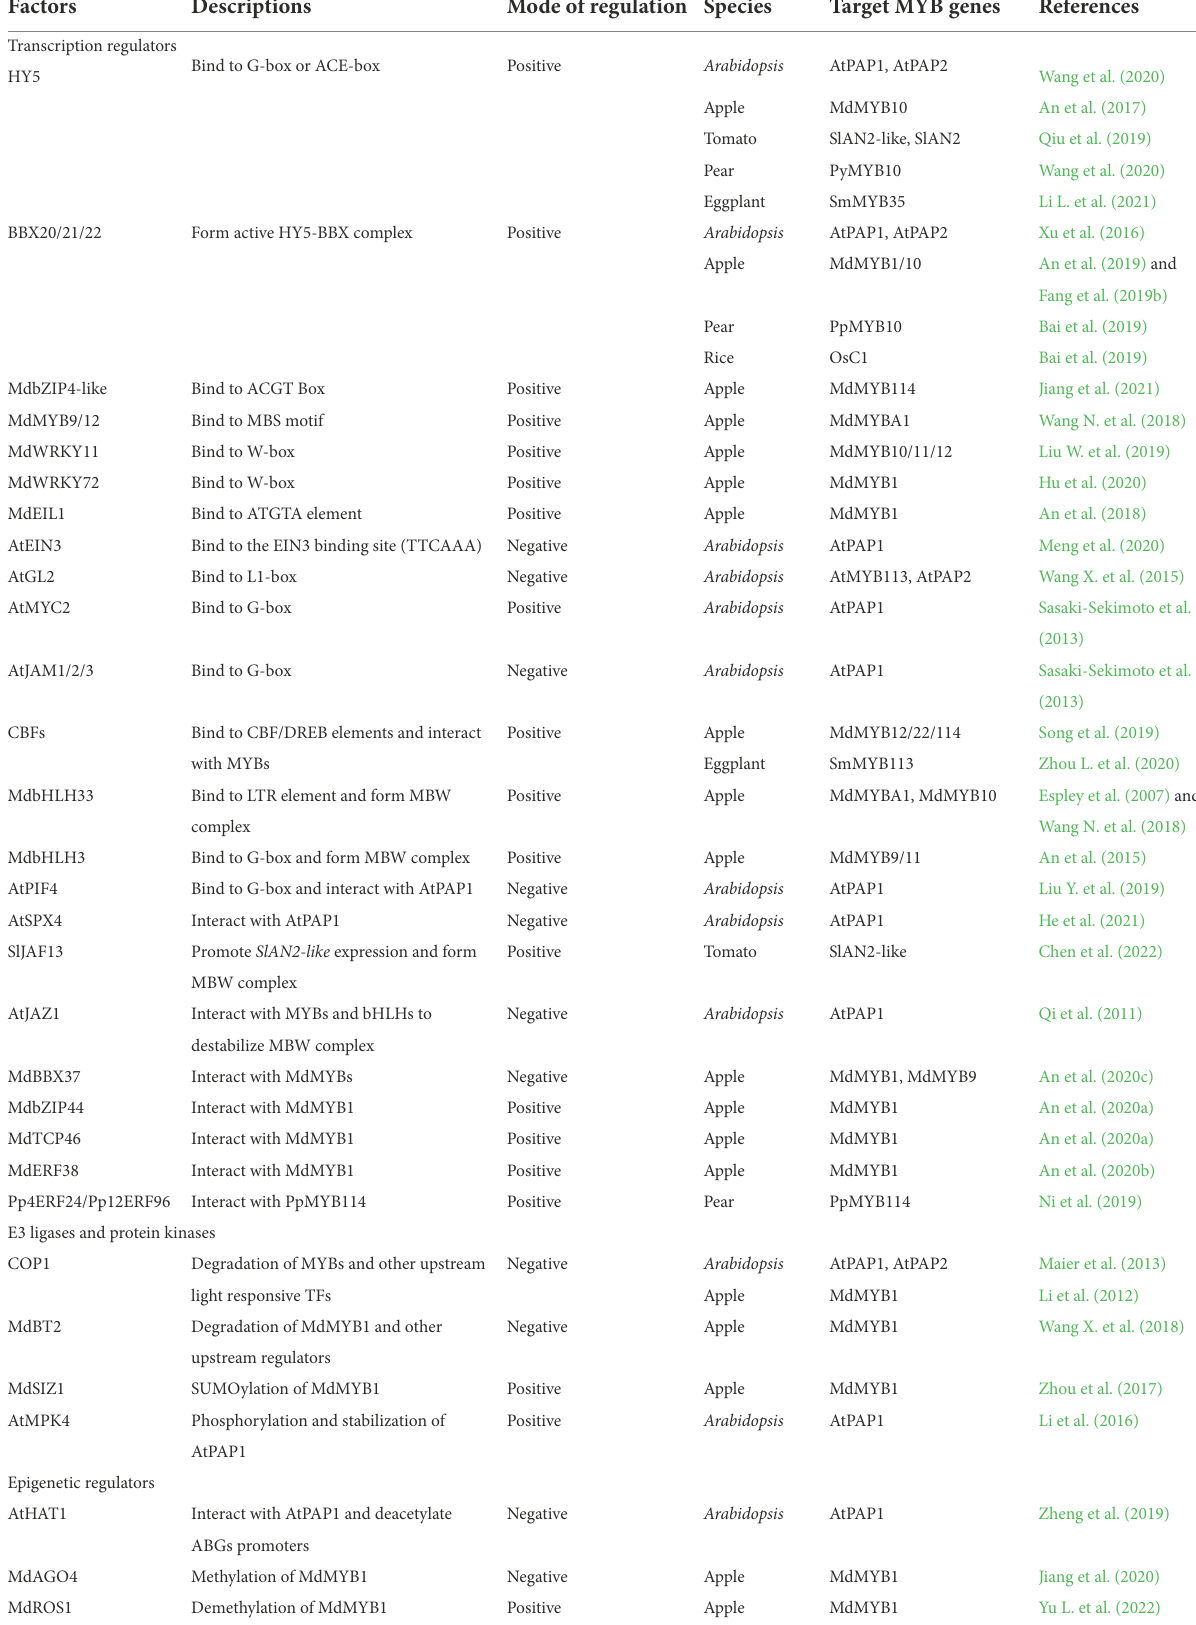
TABLE 1 Regulators involved in anthocyanin biosynthesis by targeting R2R3-MYB activators in